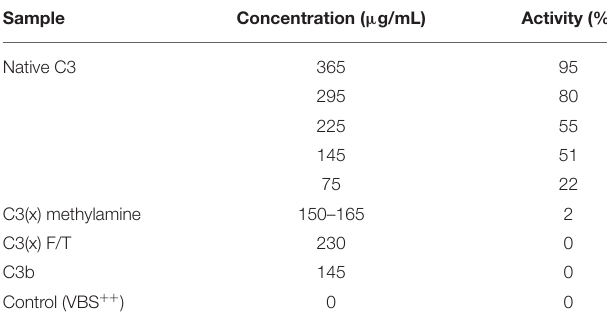
TABLE 2 | Hemolytic assay of AP with C3 added to C3 depleted serum as indicated.